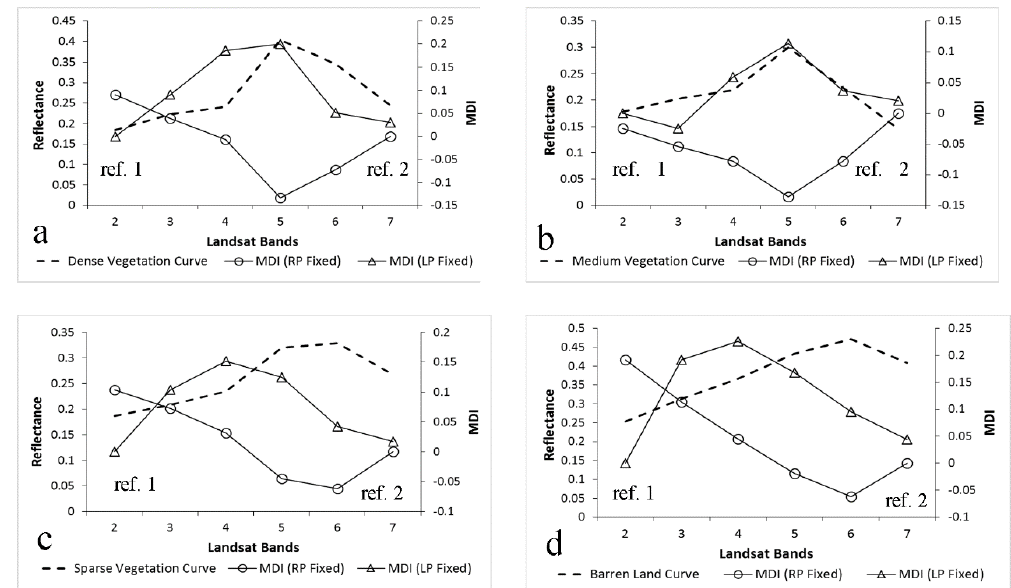
Figure 4. Sample illustrations of MDI applied to the reflectance responses of: ( a ) dense vegetation; ( b ) medium dense vegetation; ( c ) sparse vegetation; and ( d ) barren land, derived from the Landsat OLI image. The figures demonstrate the changes of the MDI values with varying PWR, moving from reference point 1 to 2, and vice versa . Maximum values are observed at maximum shape differences, usually occurring at the inclusion of a spectral curve peak or a spectral curve dip.